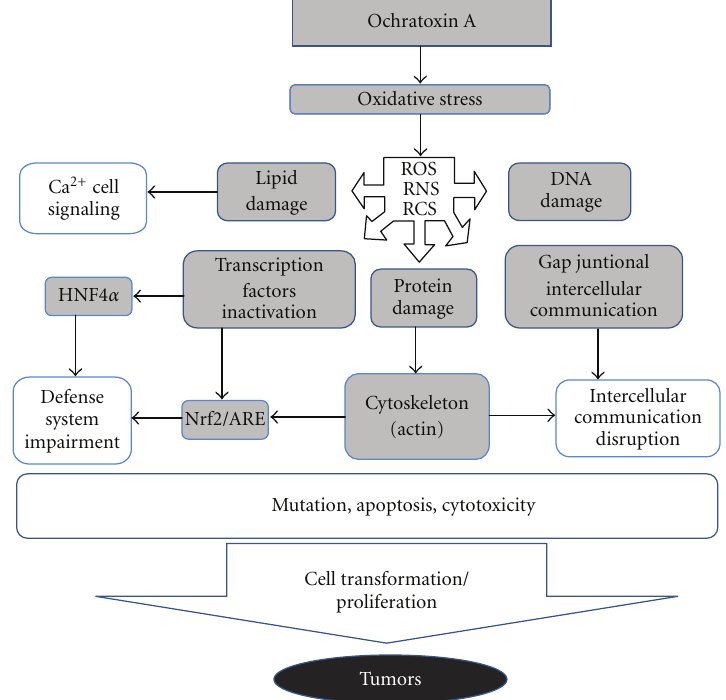
Figure 1: Scheme to illustrate the oxidative stress-mediated mode of action proposed for OTA. Increased production of ROS, RNS, and RCS is likely to originate either from direct redox reactions involving OTA or through the inhibition of cellular defenses such as through the inhibition of transcription factors as Nrf2 which regulates enzymes with antioxidant properties. The generation of radicals will induce macromolecular oxidative damage such as oxidized DNA bases which may be converted into mutation resulting into generation of transformed cells. In addition, radicals will trigger biological responses which may impair intercellular communication and induce cell proliferation as well as reduction in cellular defense in oxidative stress. This last e ff ect is likely to amplify the oxidative stress-mediated e ff ects of OTA. Altogether, these molecular mechanisms will result in cancer